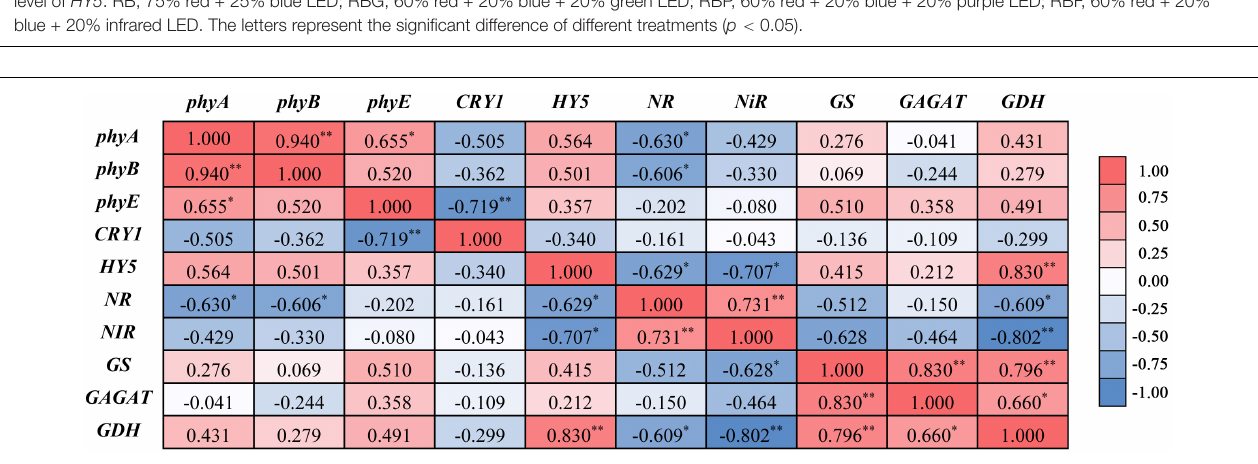
FIGURE 6 | Correlation analysis of relative expression levels between light-response genes and nitrogen metabolism genes. **Correlation is significant at the 0.01 level (2-tailed), *Correlation is significant at the 0.05 level